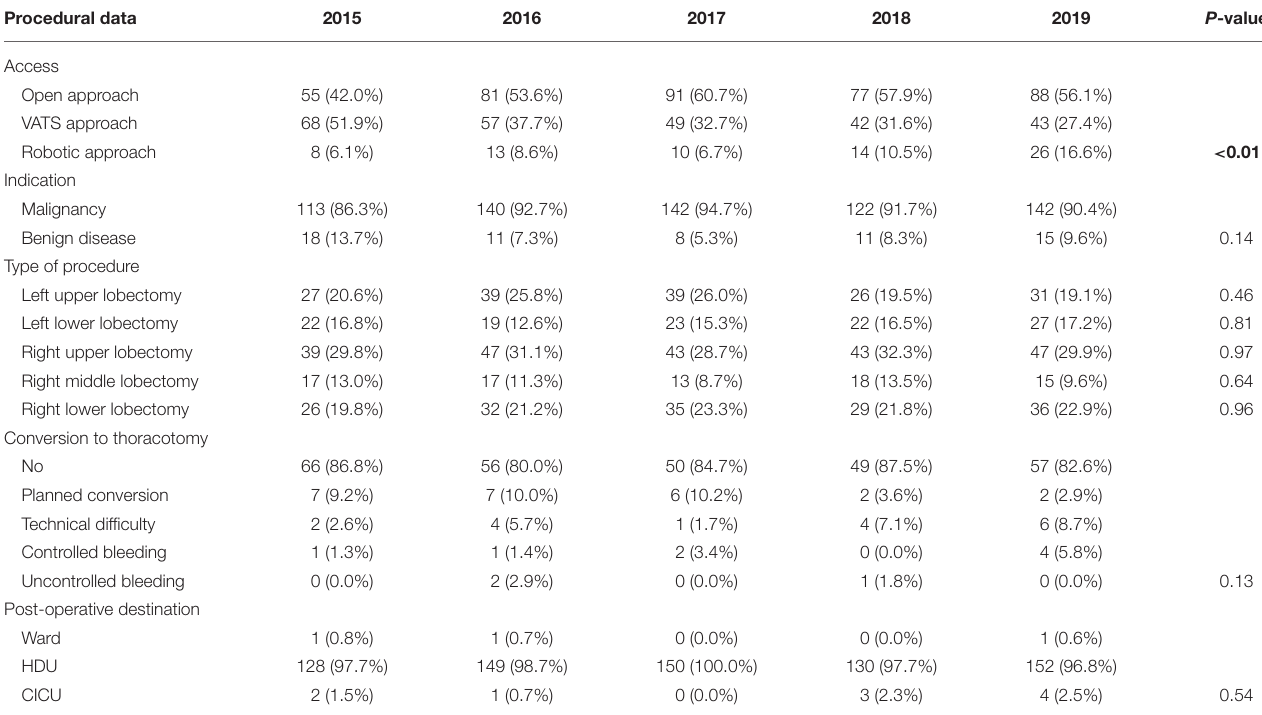
TABLE 4 | Procedural data over time.